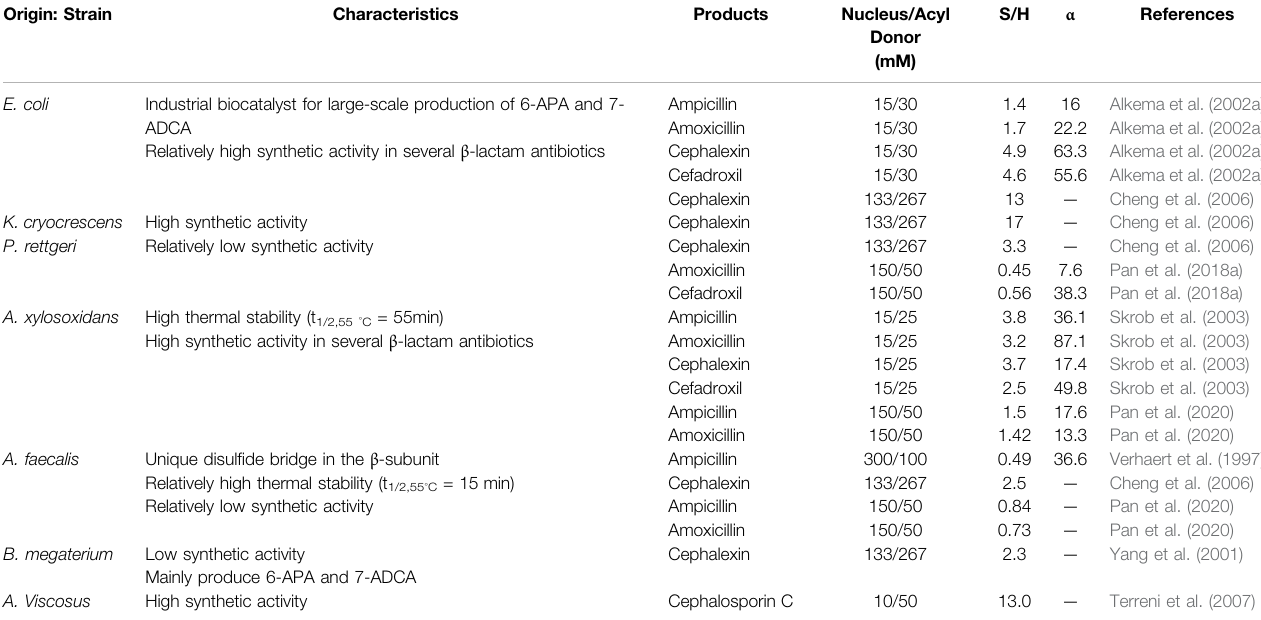
TABLE 1 | Synthesis performances of the industrially relevant PGAs reported in the literature. Origin: Strain